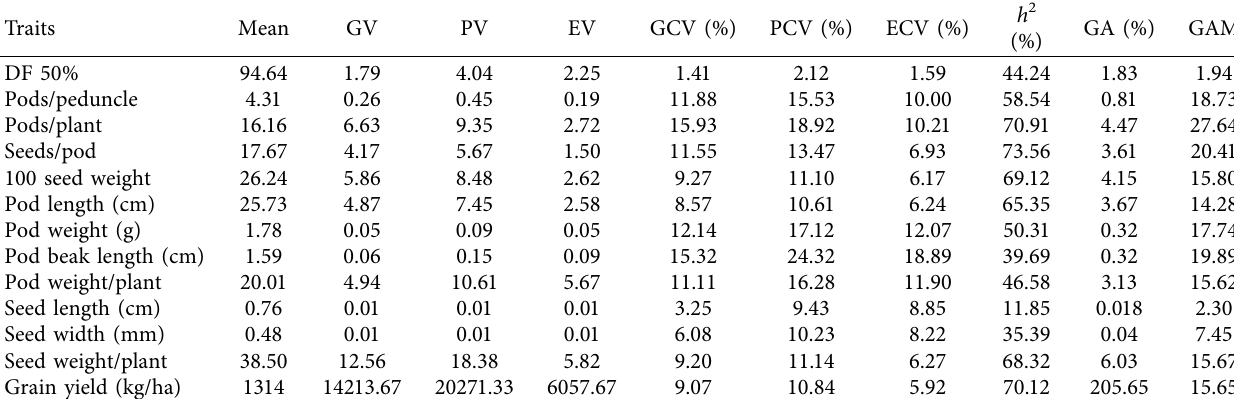
Table 6: Mean and genetic estimates of some reproductive, grain yield, and yield components of the African yam bean.